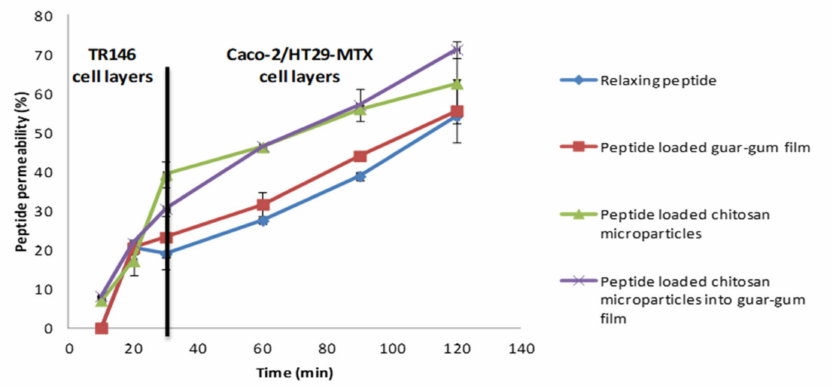
Figure 5. Cumulative relaxing peptide transport measurements across TR146 and Caco-2/HT29-MTX co-culture model in Transwell membranes expressed as peptide permeability (%, mean ± SD).